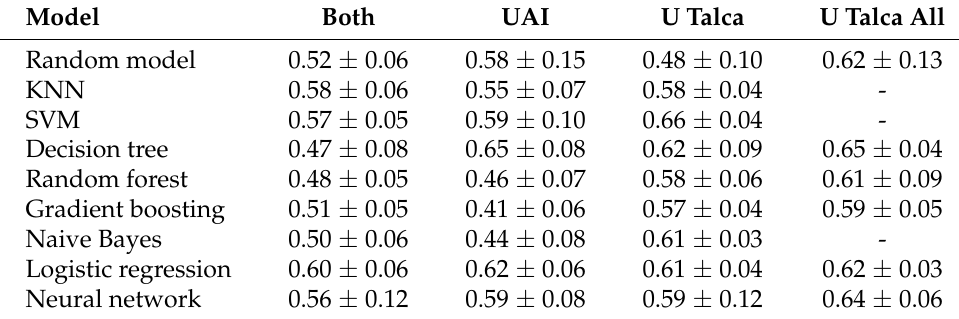
Table 4. Recall + class, for each dataset.